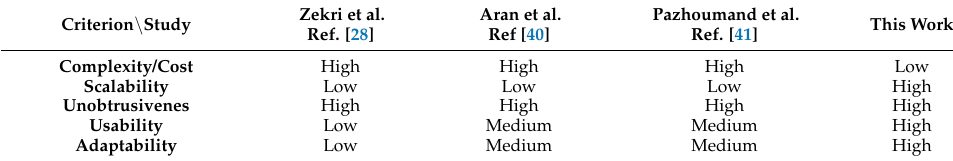
Table 2. Comparison of the proposed solution with other related work. Criterion \